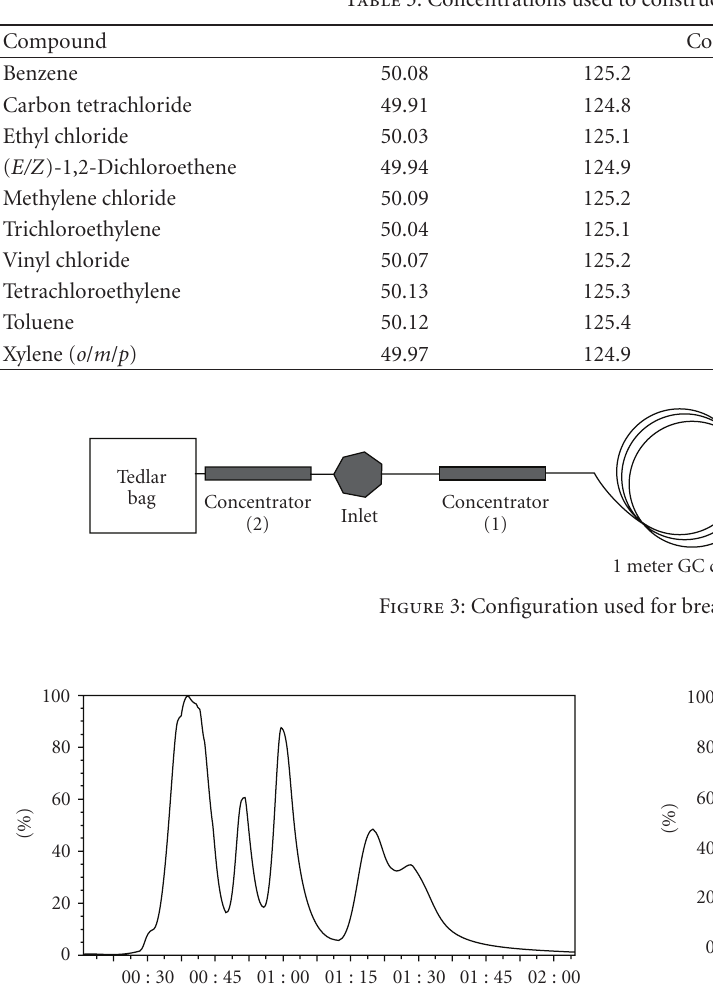
Figure 4: Total ion chromatogram (TIC) of analytes in mix 1 (Table 1) using a TriBed microconcentrator.